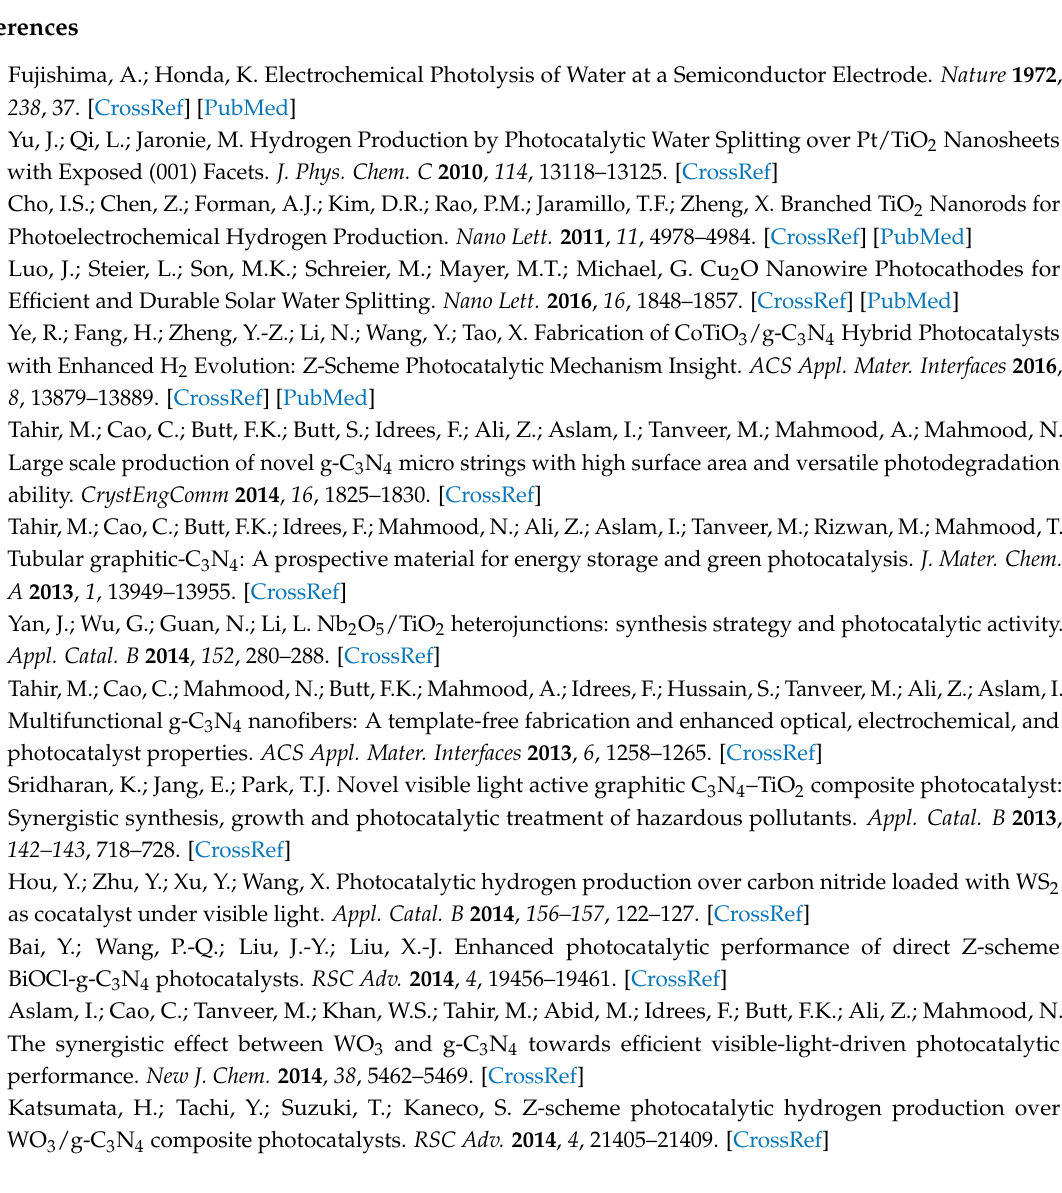
s1, Figure S1: XRD patterns BA and AA at different calcination temperatures, Figure S2: FTIR spectra of all photocatalysts, Figure S3: TEM images of NBO, Figure S4: Molecular H 2 generation of NBCN-2, Chemical and Physical Mixing in the presence of methanol, Figure S5: Bandgap vs. photon energy by UV-vis-Diffuse Absorption Spectra of a) NBO, GCN, NBCN-1, NBCN-2, NBCN-3, and NBCN-4 and b) with the change in the annealing temperature, Figure S6: Mott-Schottky plot of NBO and NBCN-2, Table S1: Associated Bands in FTIR Spectra, Table S2: Specific surface area (m 2 /g) of samples with different calcination temperatures, Table S3: Specific surface area of NBO and NBCN-X (X = 1–4) without calcination, Table S4: Liberated Amount of H 2 after 7h with and without Pt, Equation (S1) and Equation